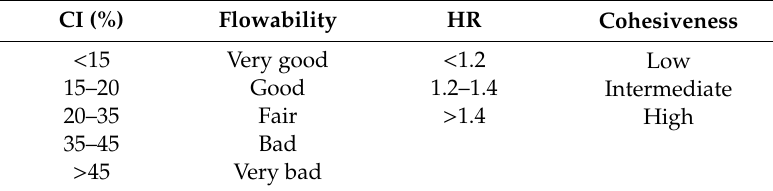
Table 1. Carr index (CI) and Hausner ratio (HR) of powders